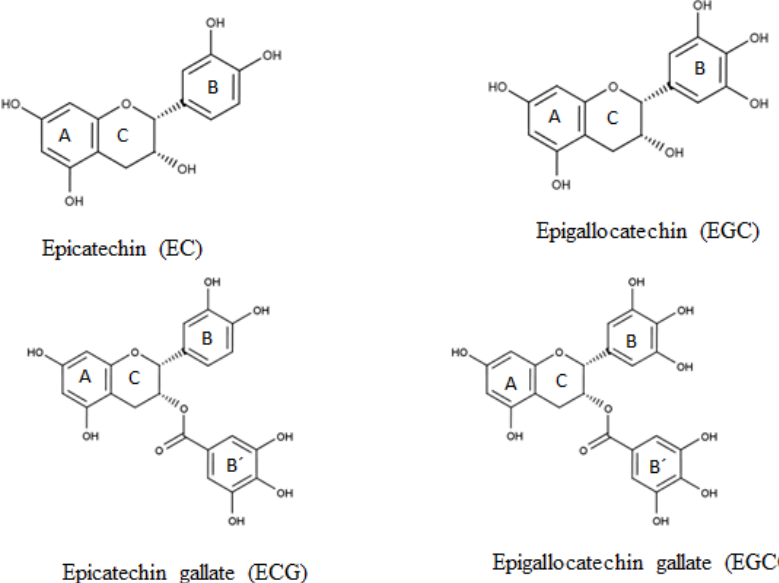
Figure 1. Chemical structure of major green tea catechins [17,19] .